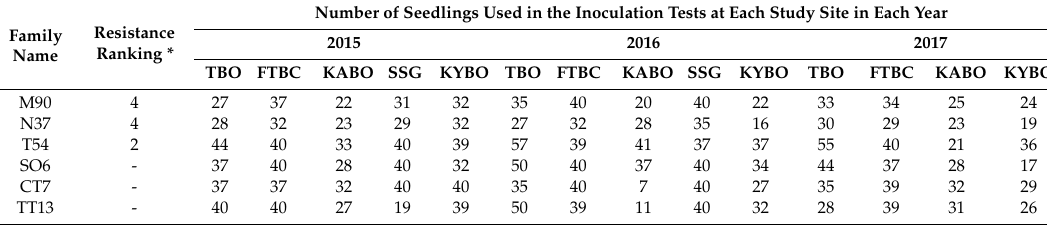
Table 1. Resistant P. thunbergii families used in this